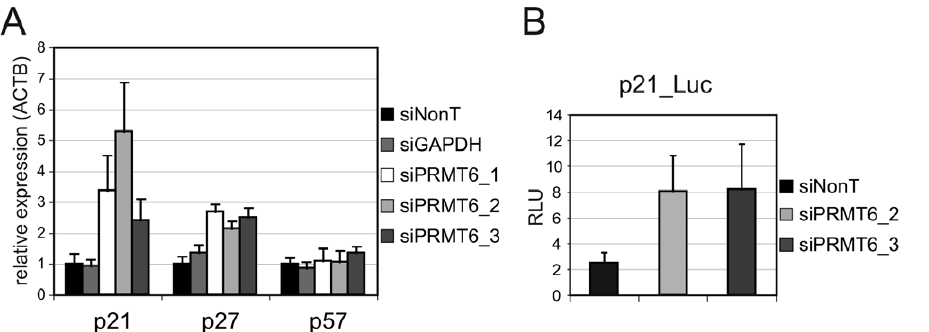
Figure 2. Transcriptional regulation of p21 and p27 by PRMT6. (A) U2OS cells were transfected with the indicated siRNAs and harvested 72 h later. RT-qPCR was performed with primers for p21, p27 and 57. Gene expression was normalized for beta-Actin. Error bars indicate the standard error of the mean. (B) Cells were transfected with p21-Luc reporter and the indicated siRNAs. Relative light units represent the mean value of a triplicate